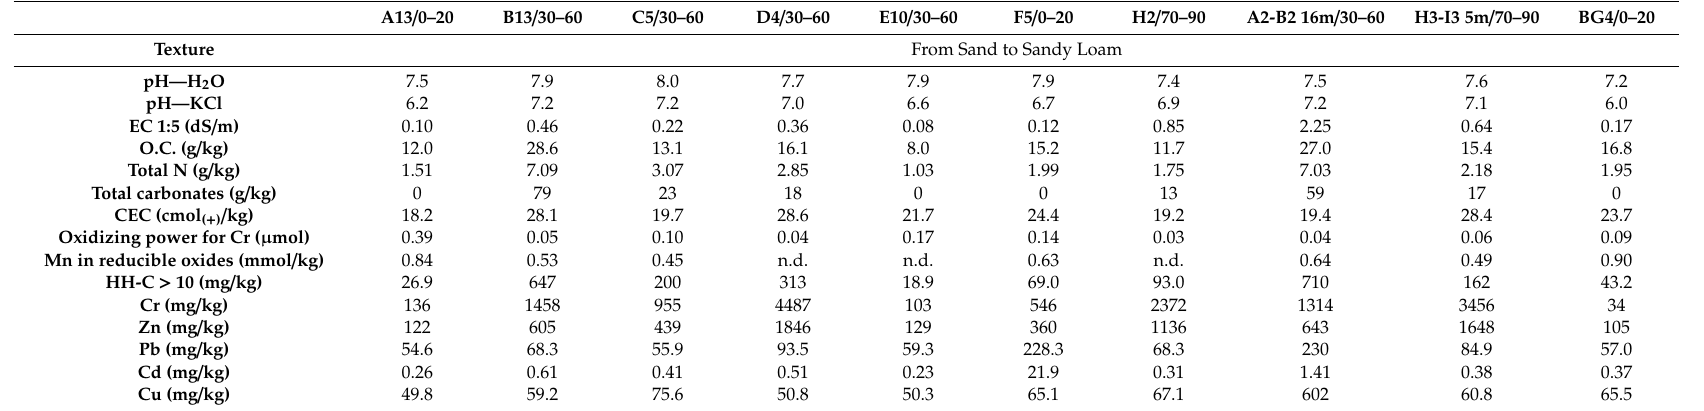
Table 2. Main chemical and physical properties and contaminant contents of the selected background (BG) and soil samples from the studied field.